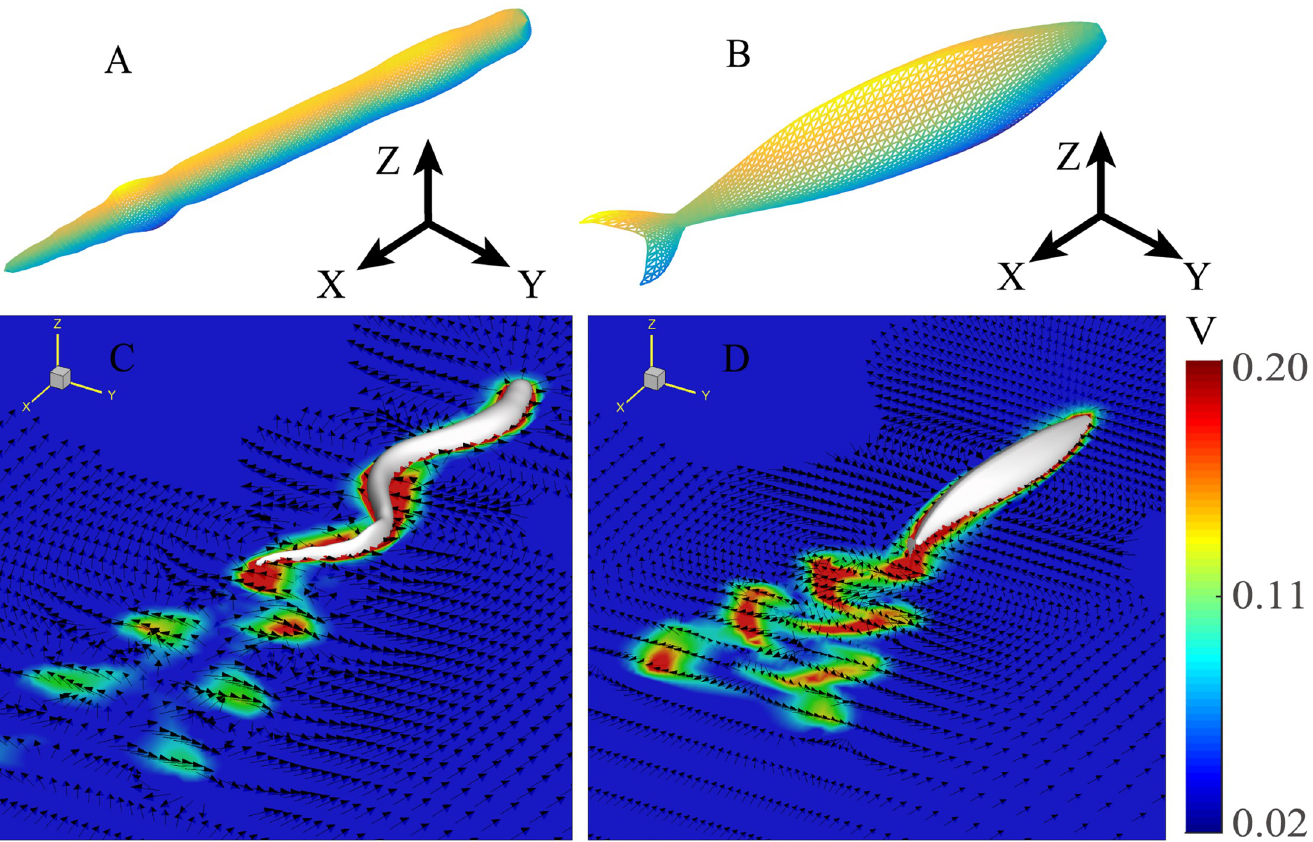
Fig 1. Numerical models. (A) and (B) are the meshes without body deformation for the eel and mackerel, respectively. Flow fields in the middle coronal planes ( z = 0) of the eel (C) and mackerel (D) models in the laboratory frame. The arrows indicate the velocity direction and the colors represent the magnitude of the velocity. Only flow speeds greater than 0.02 in nondimensionalized units are shown in